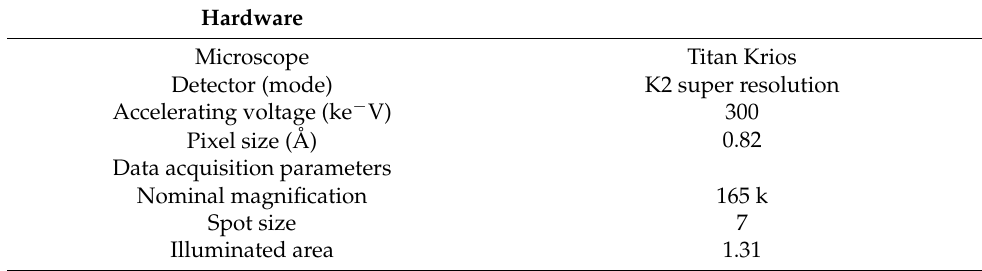
Table 2. Cryo-EM data collection and image processing information for CVA24v in complex with compound 14